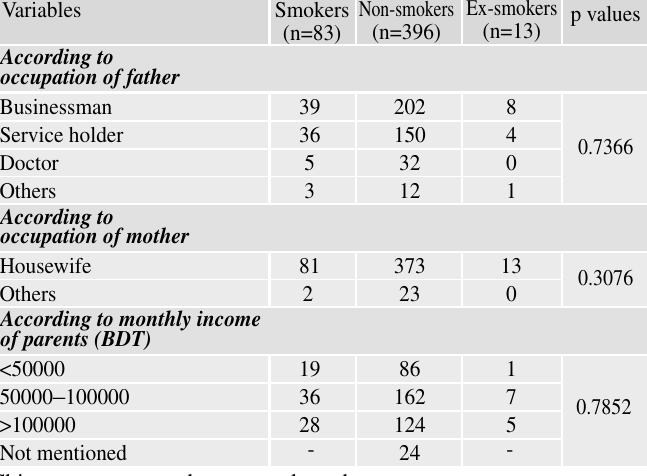
Table I: Distribution of study subjects according to occupation and monthly income of the